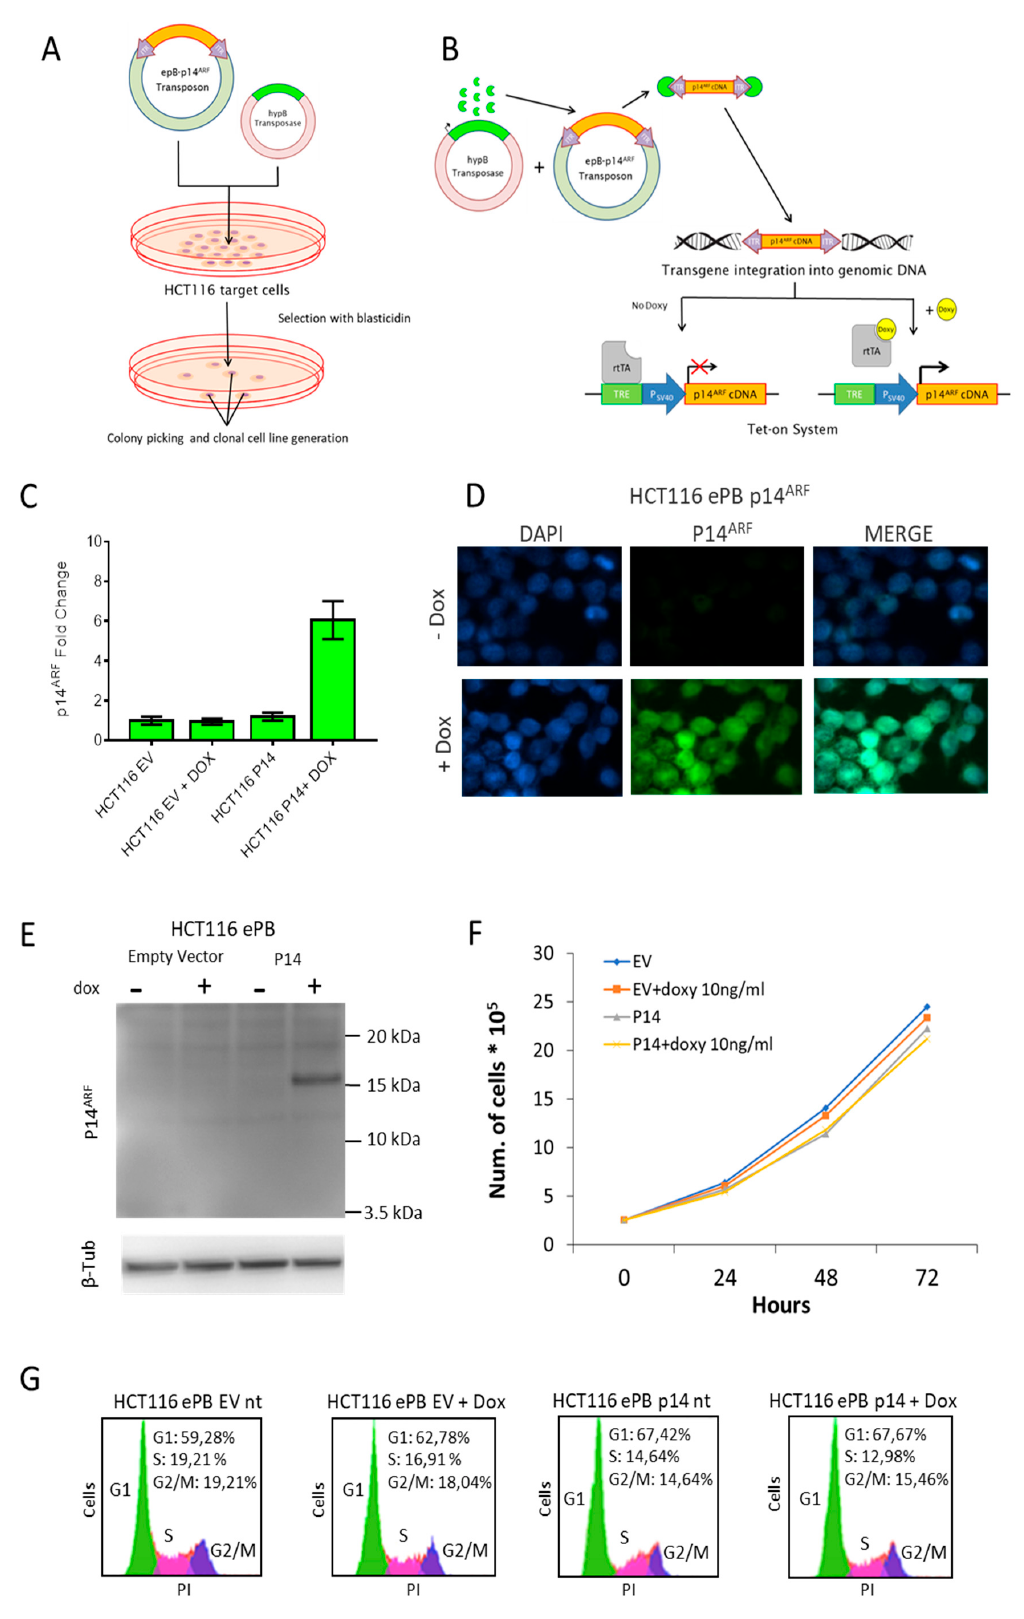
Figure 1. Generation and characterization of a monoclonal HCT116 cell line harbouring the p14 ARF cDNA. ( A ) Experimental schematics of the monoclonal cell line generation. ( B ) Outline of the